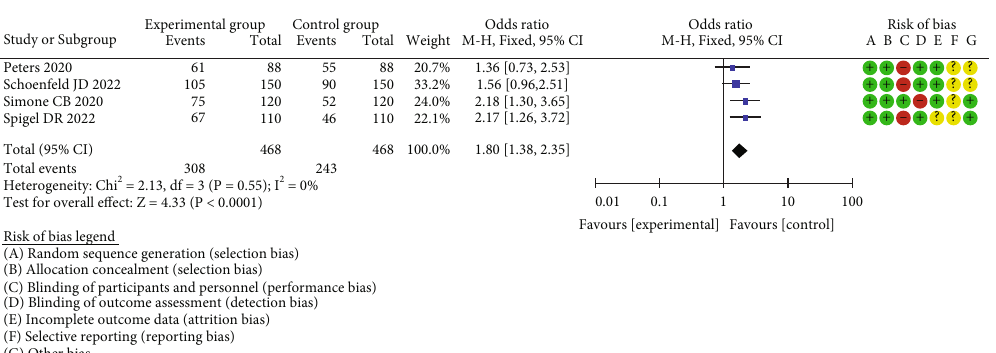
Risk of bias legend (A) Random sequence generation (selection bias) (B) Allocation concealment (selection bias) (C) Blinding of participants and personnel (performance (D) Blinding of outcome assessment (detection bias) (E) Incomplete outcome data (attrition bias) (F) Selective reporting (reporting bias) (G) Other bias Figure 2: Meta-analysis of e ffi cacy comparison between experimental group and control group in non-small-cell lung cancer.